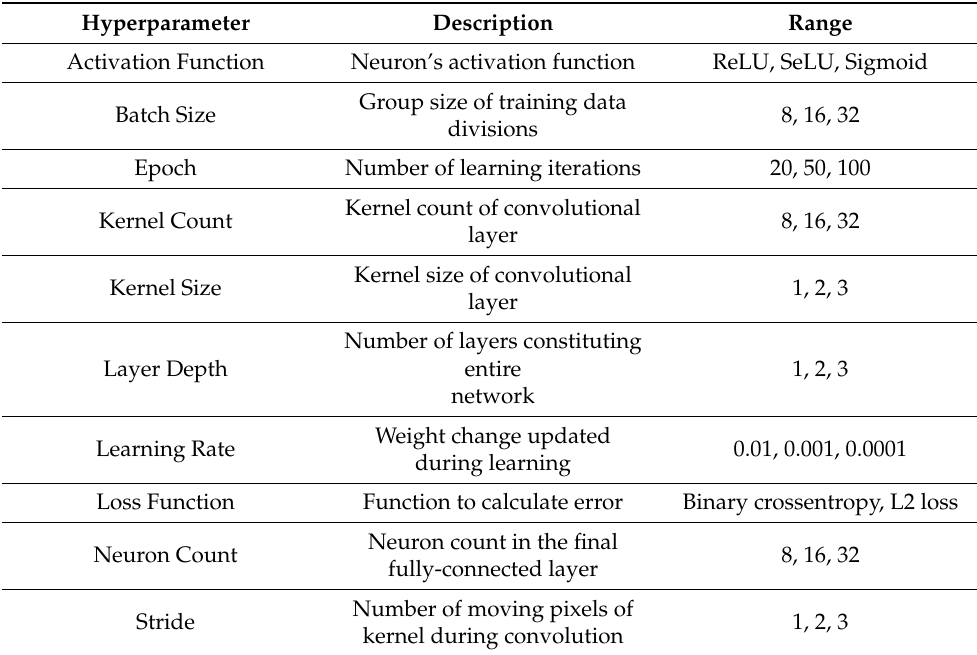
Table 2. Hyperparameters and their range for CNN